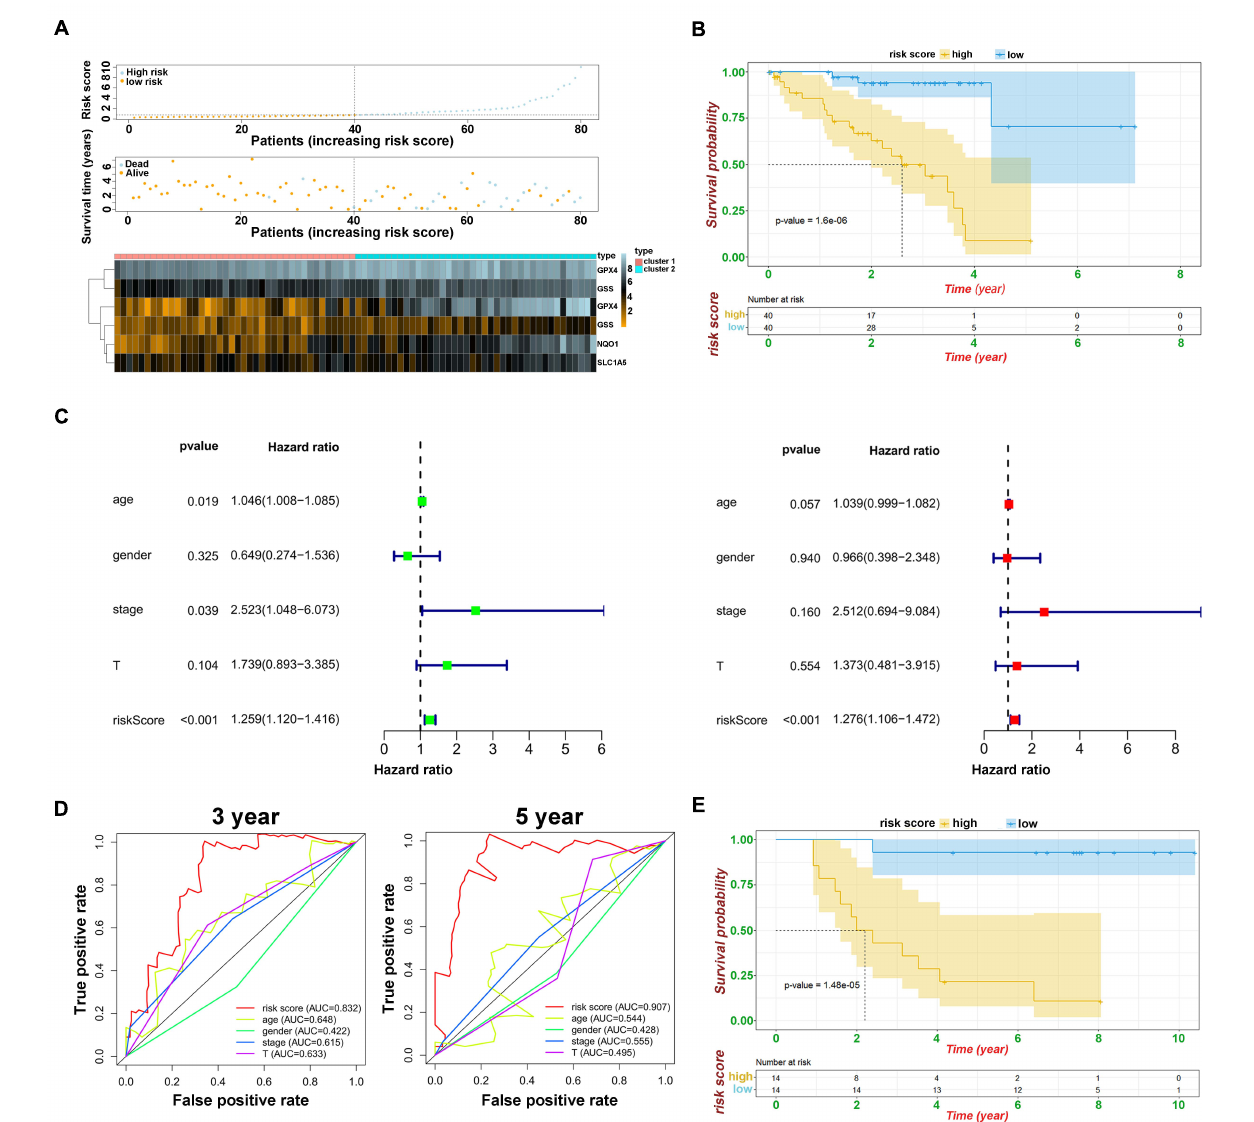
FIGURE 5 | Prognostic analysis of risk model and ferroptosis-related genes. (A) The distributions of risk scores, alive/dead status, and expression of ferroptosis-related genes in module A. (B) Kaplan–Meier curves of patients in high/low risk about OS in module A. (C) Univariate (above) and multivariate analysis (below) of clinical characteristics. (D) ROC curve of risk score and clinical characteristics in module A. (E) Kaplan–Meier curves of patients in high/low risk about OS based on